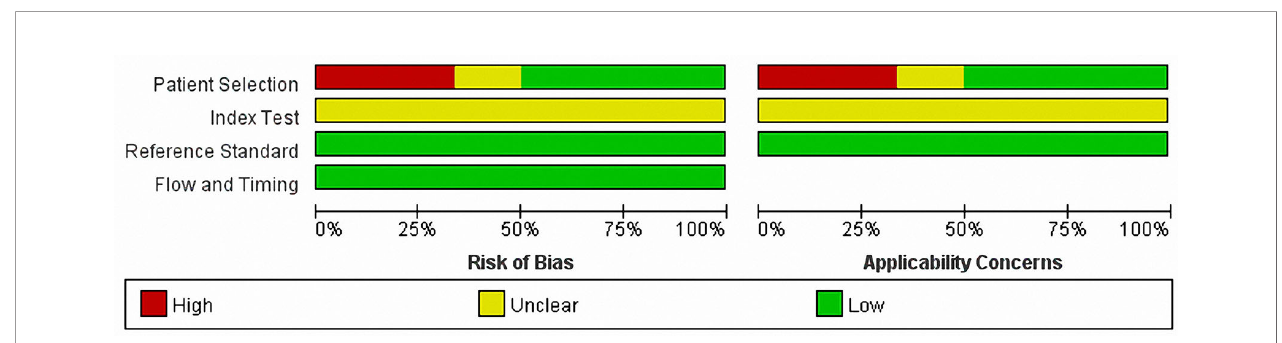
FIGURE 6 | QUADAS-2 risk of bias and applicability concerns graph showing review authors ’ judgments about each domain as percentages of included studies. QUADAS-2, the revised Quality Assessment of Diagnostic Accuracy Studies.